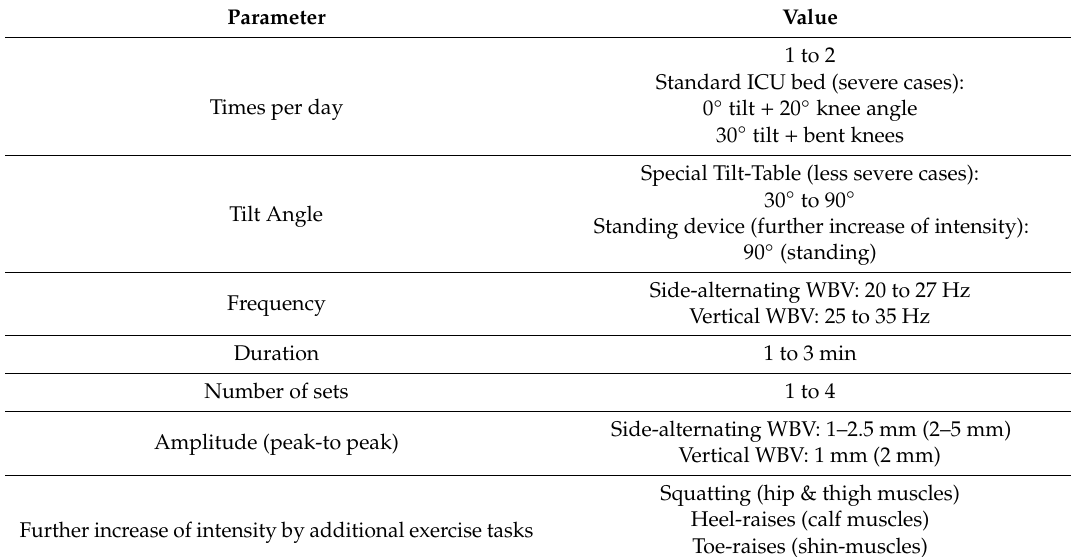
Table 4. Parameters to alter training intensity for side-alternating and vertical whole-body vibration training devices